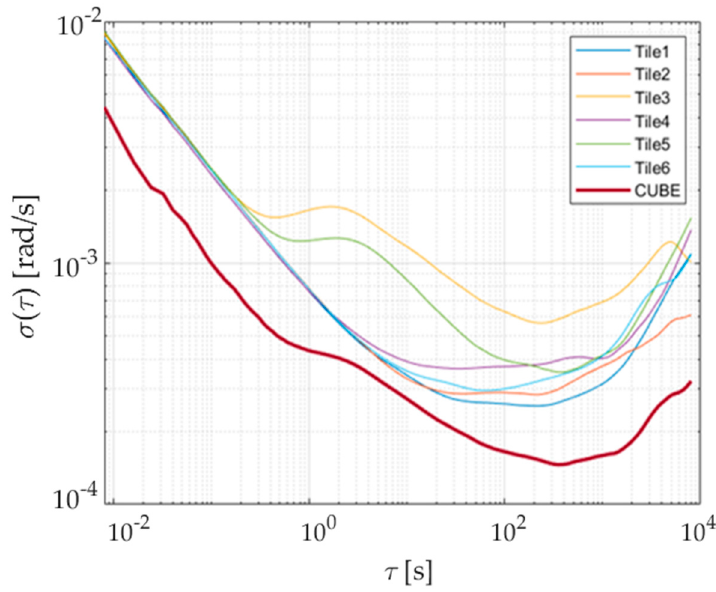
Figure 9. Allan deviation of accelerometers, axis z : single SensorTile vs. prototype.